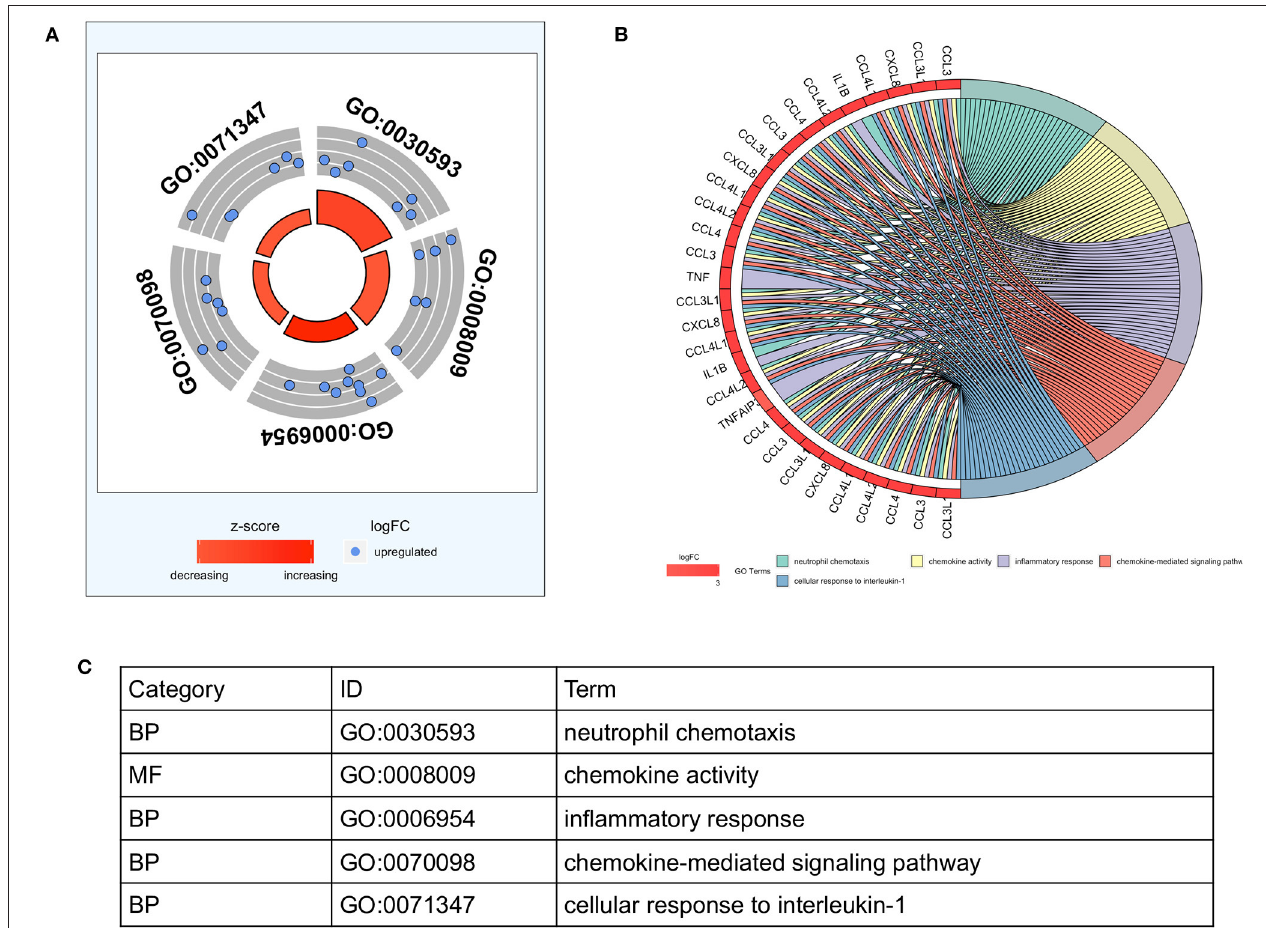
FIGURE 2 | Functional enrichment analysis of 19 differentially expressed genes (DEGs) in pSS associated thrombocytopenia. (A) The outer circle represents the expression (log FC) of DEGs in each enriched GO (gene ontology) term: blue dots on each GO term indicate upregulated DEGs. The inner circle indicates the significance of GO terms (log10-adjusted P -values). (B) The circle indicates the correlation between the top 9 DEGs and their gene ontology terms. (C) The distribution of DEGs in significant GO terms. DEGs, differentially expressed genes; pSS, primary Sjögren’s syndrome; FC, fold change; BP, biological process; MF, molecular